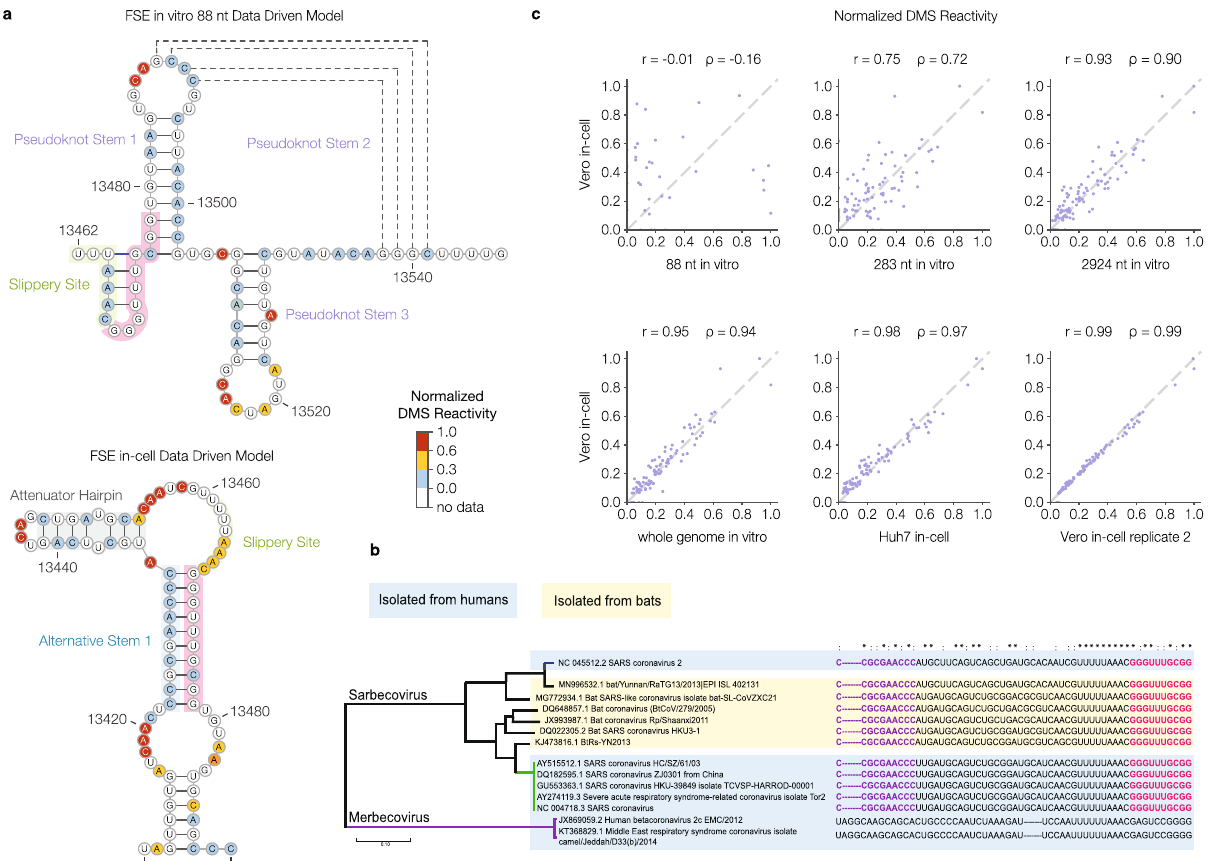
Fig. 4 The frameshifting stimulation element (FSE) adopts an unexpected structure in cells. a Predicted structures of the FSE derived from DMS- MaPseq on in vitro-transcribed 88 nt RNA (top) and infected Vero cells (bottom). For the 88 nt RNA, reads were clustered into K = 3 clusters; in the cluster with the largest fraction of reads (60%), the given pseudoknot was among the three minimum-energy structures. Nucleotides are colored by normalized DMS reactivities (see Methods). The 5 ′ and 3 ′ sides of the alternative stem 1 (AS1) are highlighted in blue and pink, respectively (bottom), and the sequence that forms the 3 ′ side of AS1 is also highlighted in pink in the top structure. b Sequence conservation of FSE alternative stem 1 pairing. The 5 ′ and 3 ′ sequences of alternative stem 1 are highlighted in purple and pink, respectively. Symbols above the sequences indicate perfect conservation among all viruses in the alignment (*) or perfect conservation among only the sarbecoviruses (:). Source data are provided as a Source Data fi le. c Scatterplots of DMS reactivities over the FSE, comparing infected Vero cells and other contexts: 88 nt, 283 nt, or 2924 nt RNA fragments containing the FSE folded in vitro; whole genomic RNA extracted from virions and refolded in vitro; infected Huh7 cells; and a replicate of infected Vero cells. In each sample, DMS reactivities have been normalized by dividing by the maximum reactivity. For each comparison, the Pearson ( r ) and Spearman ( ρ ) correlation coef fi cients are